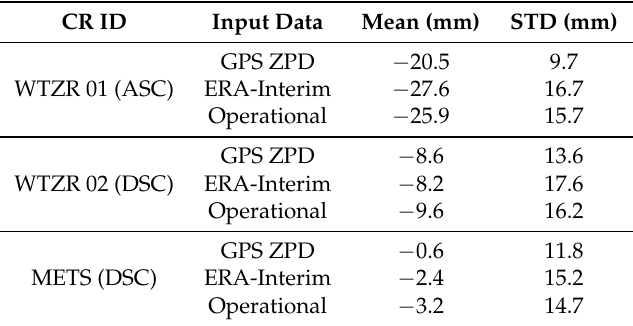
Figure 5. Correlation analysis of absolute localization residuals of both CRs in WTZR: ( a ) scatter plot of the mapped range delay based on GPS ZPD (GPS SPD) and the SAR range residuals (SAR SPD). ( b ) scatter plot of the range delays integrated using ERA-Interim data (ECMWF SPD) and SAR SPD. ( c ) scatter plot of the range delays integrated using OP data (ECMWF SPD) and SAR SPD. Each dot represents a SAR acquisition, which is color coded according to the different incidence angle classes: ∼ 30 ◦ in blue; ∼ 40 ◦ in red and ∼ 50 ◦ in green. Table 3. Validation results using SAR SPDs as